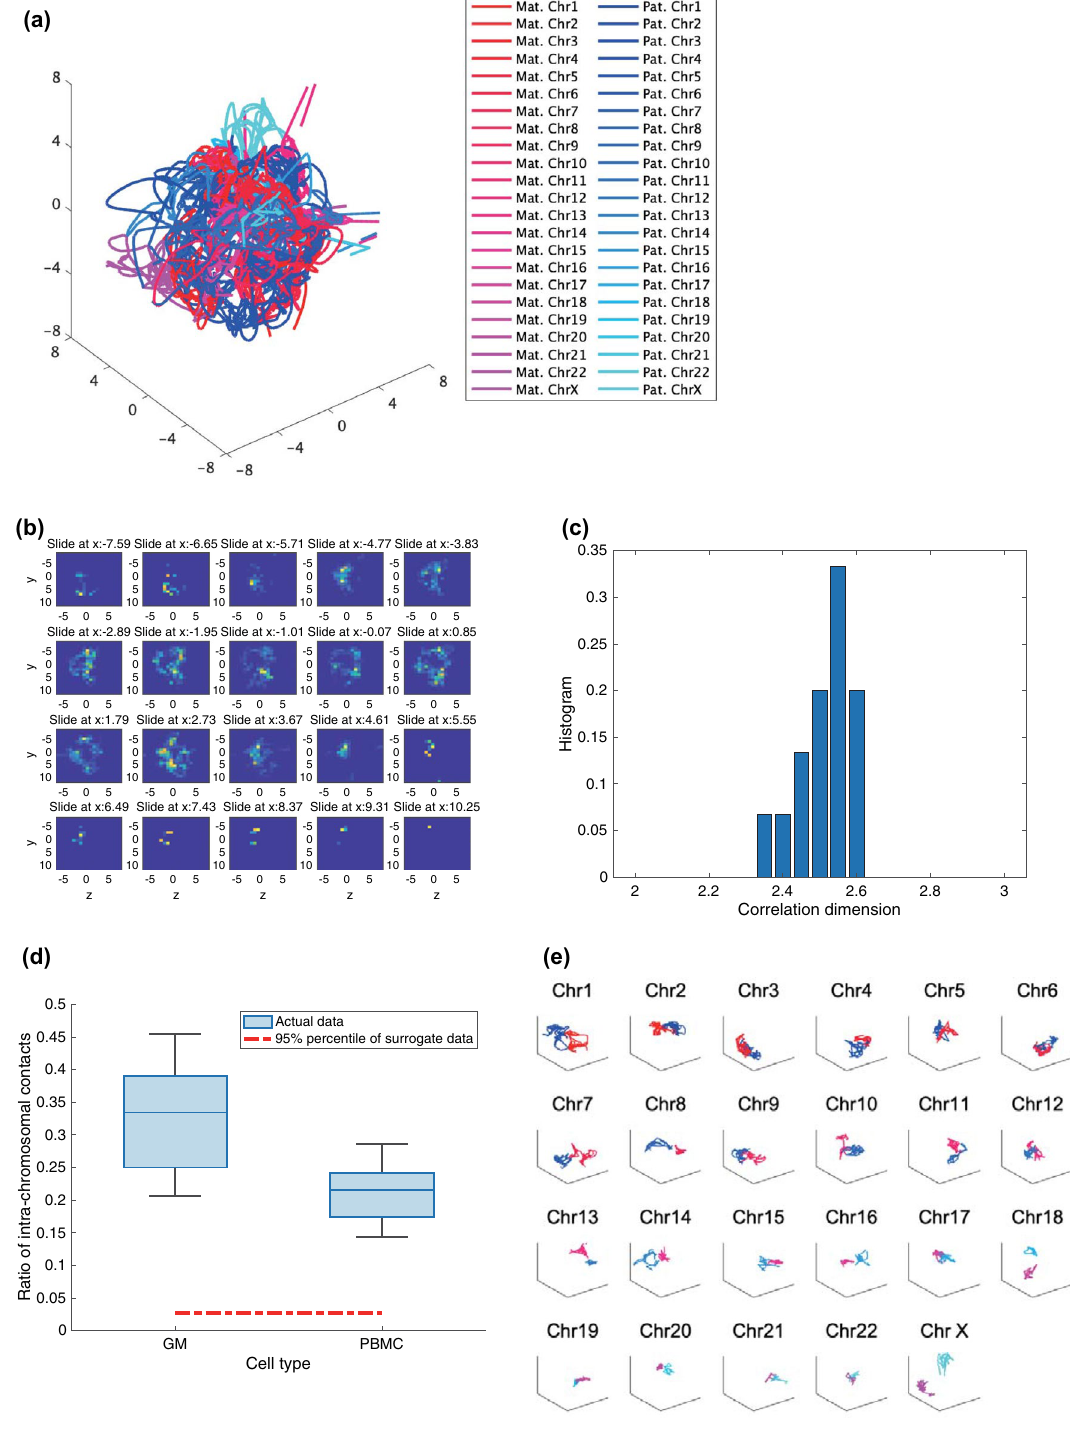
Figure 2. 3D structure for the reconstructed chromosomes from single-cell Hi-C data. ( a ) Our 40-kb reconstruction for GM cell 2. ( b ) Density plot for GM cell 2 at a 40-kb resolution. There is a hole in the center. ( c ) Correlation dimensions for GM cells at a 100-kb resolution. The correlation dimensions are not integer, implying the fractalness for the underlying chromosome structure. ( d ) Ratio of intra-chromosomal contacts for GM cells as well as PBMC cells at a 100-kb resolution compared with 20 randomly shuffled reconstructions. Panel ( d ) means that there are chromosomal territories for each of GM and PBMC cells. Panel ( e ) shows the three-dimensional structures with more detail for GM cell 2. Each sub-panel shows a chromosome where reddish and bluish colors, which are the same as Panel ( a ), indicate maternal and paternal alleles,